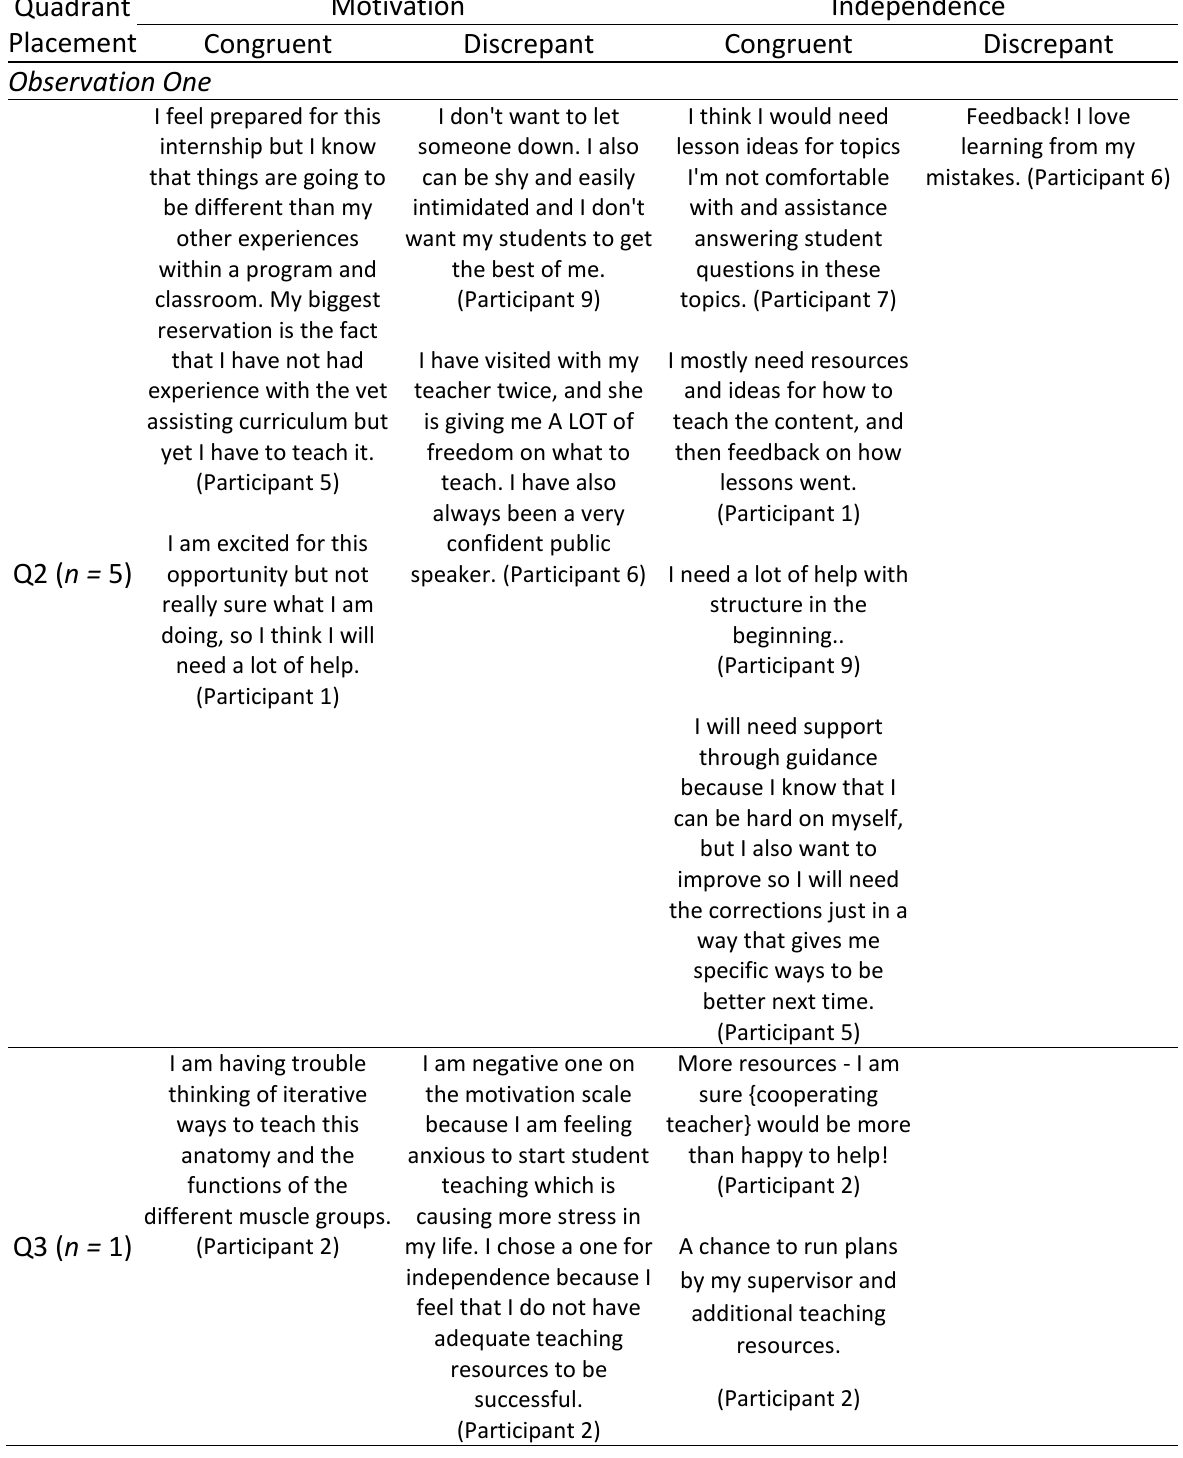
Comparing Preservice Teachers’ Descriptions o f Motivation and Independence with Their